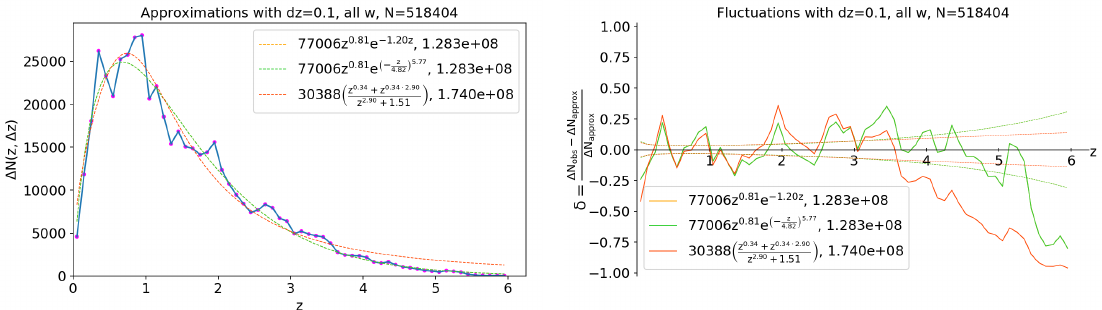
Figure 2. ( left ) Histogram of the radial distribution of photometric redshifts from the COSMOS2015 catalogue in the range 0 < z < 6 for 518,404 galaxies within bins ∆ z = 0.1, and the approximations. Dotted lines mark the least-squares fittings. ( right ) The fluctuation pattern. Dotted lines mark Poisson noise 5 σ